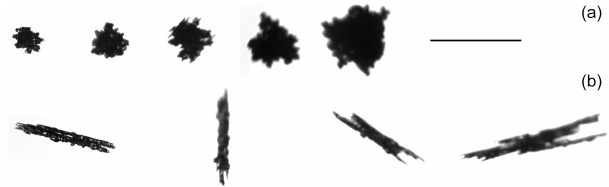
Figure 8. Example images of the two shapes, graupel (a) and rimed needles (b) , from the snowfall measured on 19 October 2014. For reference, a size bar with length corresponding to 1mm is shown.